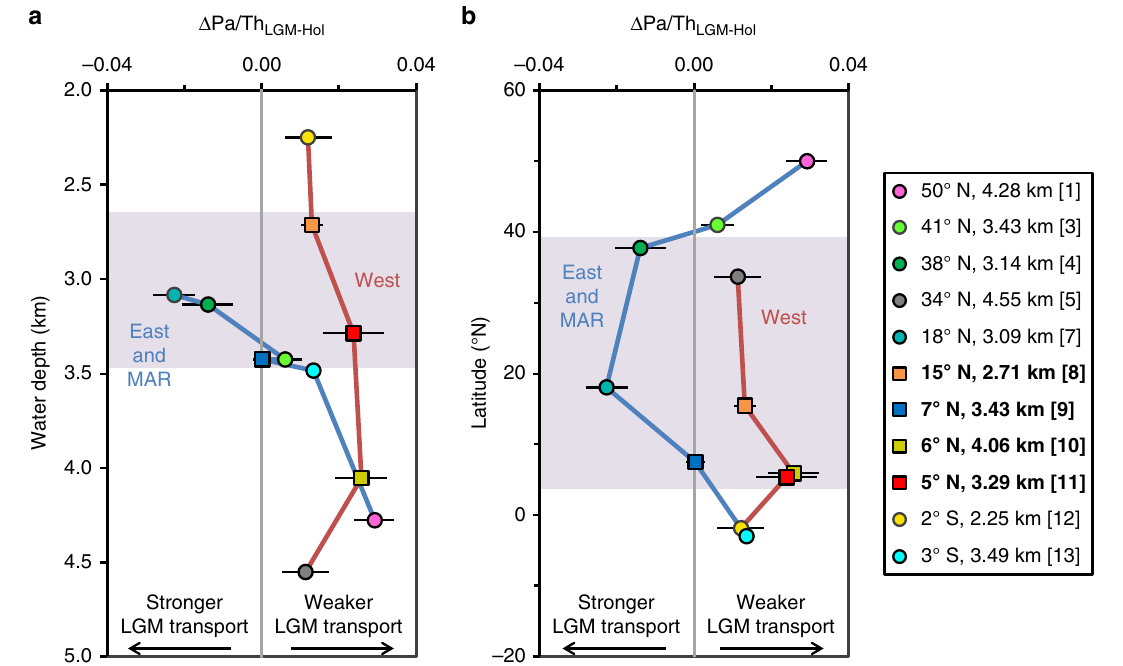
Fig. 4 Differences in averaged 231 Pa/ 230 Th values between the LGM (~22 – 19 ka) and late Holocene ( ≤ 5 ka) ( Δ Pa/Th LGM-Hol ). a Δ Pa/Th LGM-Hol versus water depth and b Δ Pa/Th LGM-Hol versus latitude. The calculation was carried out based on the thirteen Atlantic 231 Pa/ 230 Th time-series selected for interpretation of deep Atlantic circulation (Fig. 2). The Δ Pa/Th LGM-Hol plots have eleven data points as one Bermuda Rise core (34° N, 4.58 km) and the Newfoundland margin core (42° N, 4.11 km) do not have Holocene data. Purple shading indicates an East-West contrast in the Δ Pa/Th LGM-Hol at mid- latitude and low latitudes of the North Atlantic. Error bars represent 95% con fi dence interval of the averaged 231 Pa/ 230 Th values, and represent 2 s.e.m when there is only one data point in each site at each time period. The red and blue lines connect the sites from the West Atlantic and the sites from the East Atlantic and MAR,